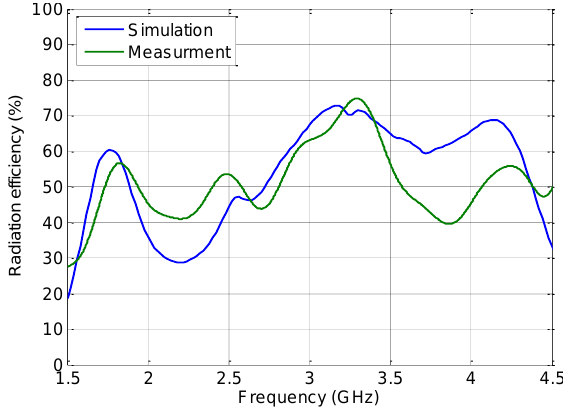
Figure. 8. Comparison of simulated and measured antenna